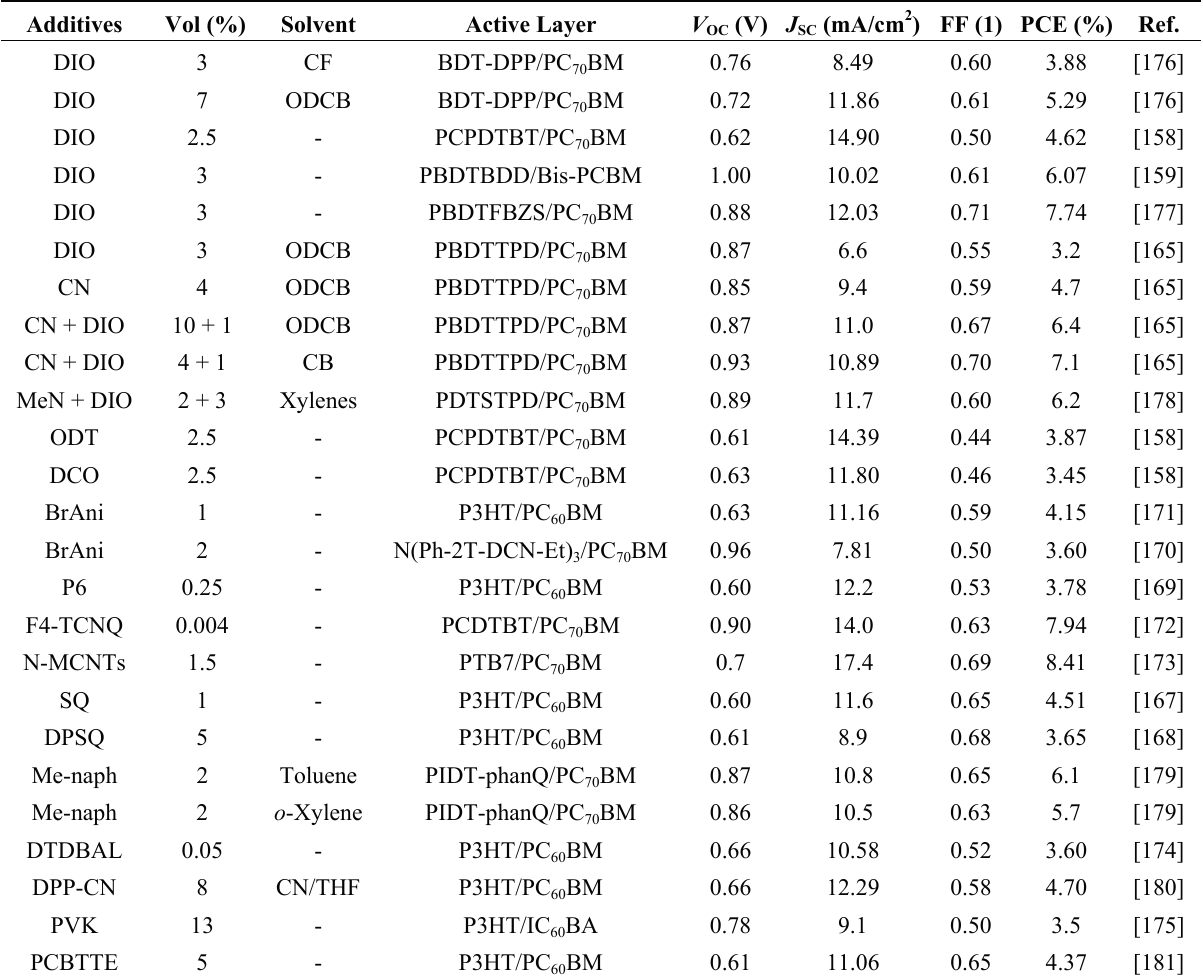
Table 2. Summary of device characteristics of OPVs based on various